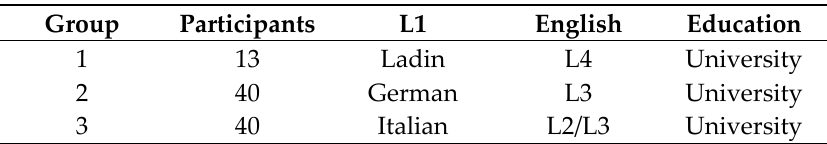
Table 2. Participants who described the climb